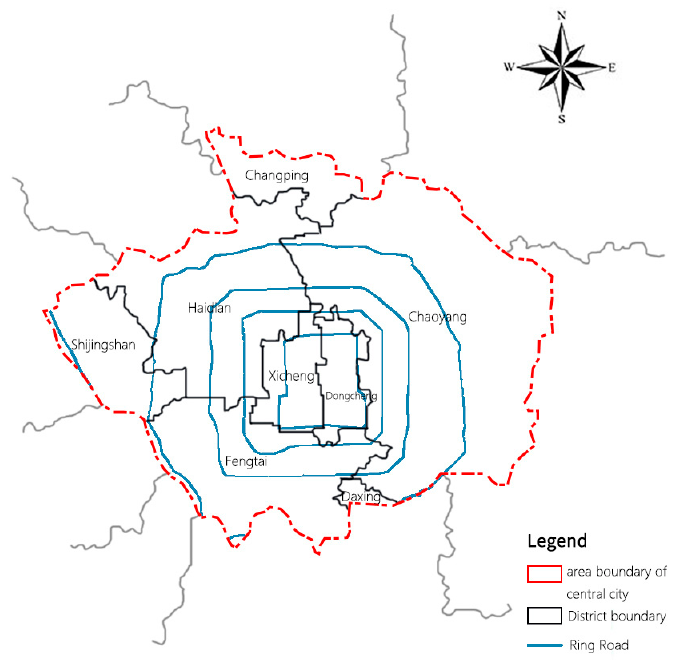
Figure 2. The location of the study area.